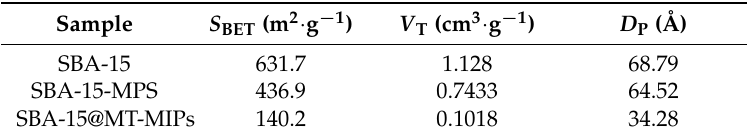
Table 2. Porosities of polymers determined by N 2 adsorption-desorption